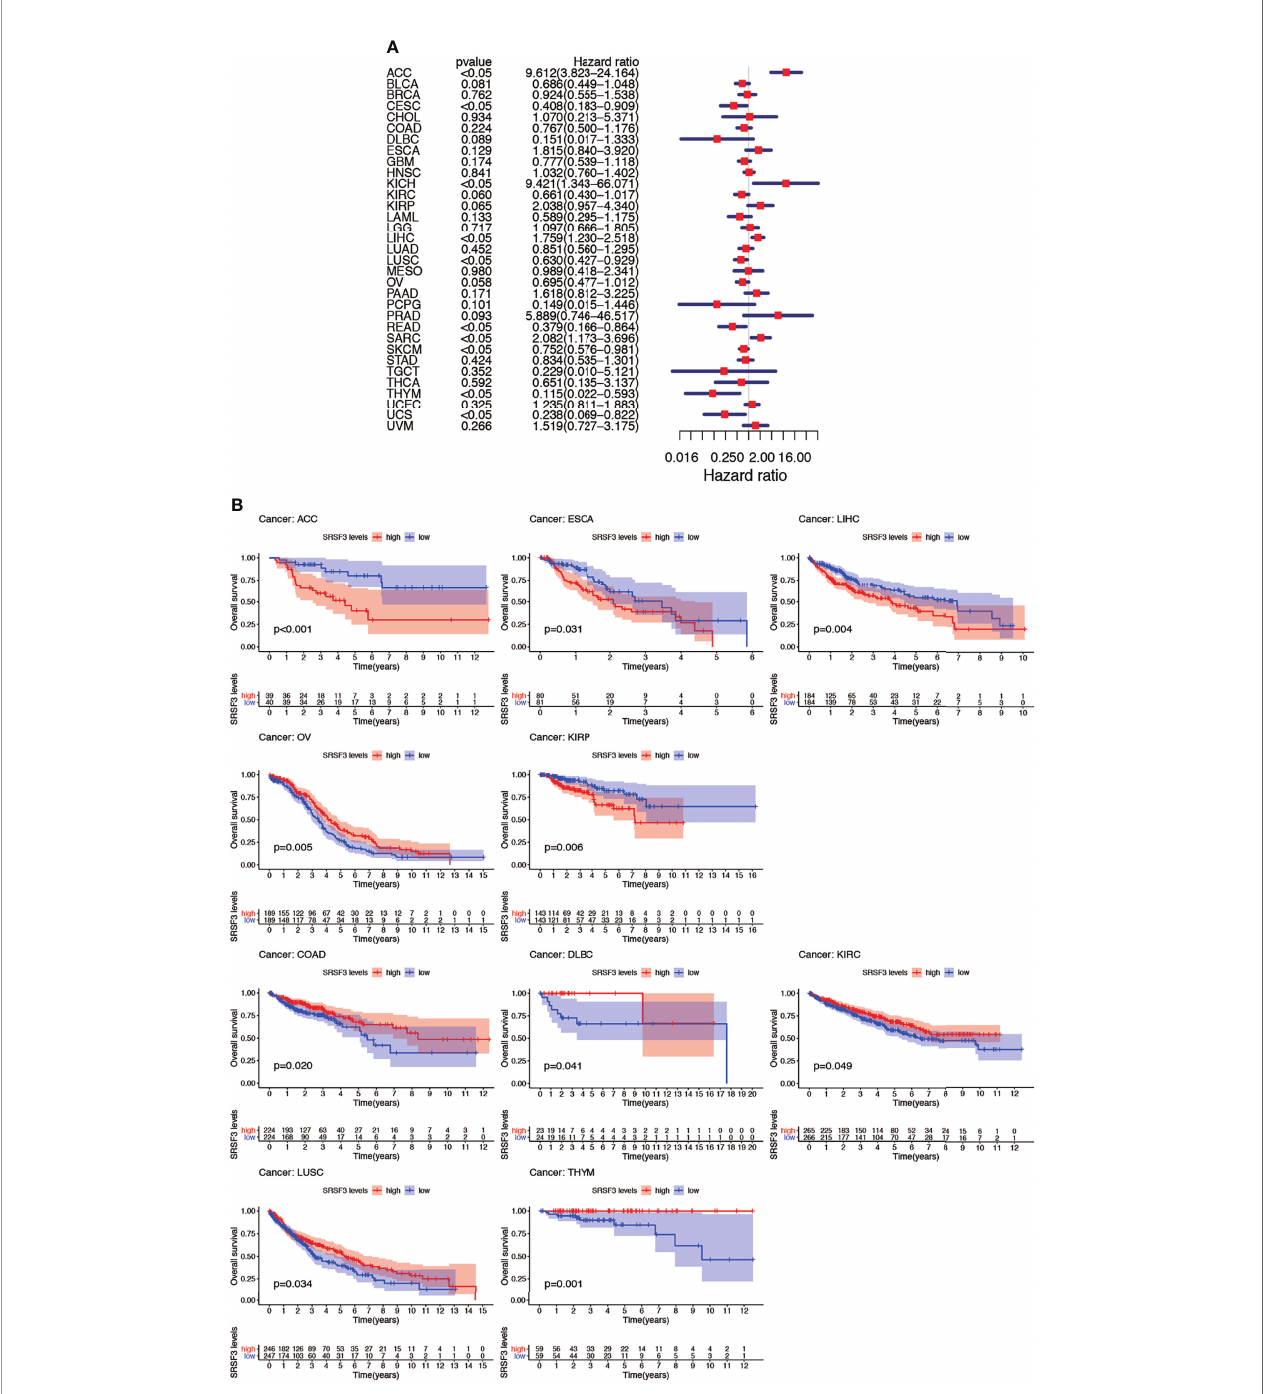
FIGURE 3 | Association between expression levels of SRSF3 and OS in different tumors from the TCGA database. (A) Cox regression analysis showed that upregulated SRSF3 expression was signi fi cantly associated with worse prognosis in ACC, ESCA, KIRP, and LIHC cancer. Upregulated expression of SRSF3 was signi fi cantly associated with better prognosis in COAD, DLBC, KIRC, LUSC, OV, and THYM cancer. P < 0.05 is considered to be statistically signi fi cant. (B) OS difference between high and low SRSF3 expression groups (divided by median expression values) in signi fi cant prognosis-related tumors from TCGA database. OS difference between groups in ACC. OS difference between groups in COAD. OS difference between groups in DLBC. OS difference between groups in ESCA. OS difference between groups in KIRC. OS difference between groups in KIRP. OS difference between groups in LIHC. OS difference between groups in LUSC. OS difference between groups in OV. OS difference between groups in THYM. P < 0.05 is considered to be statistically signi fi cant and dash lines represents 95% con fi dence